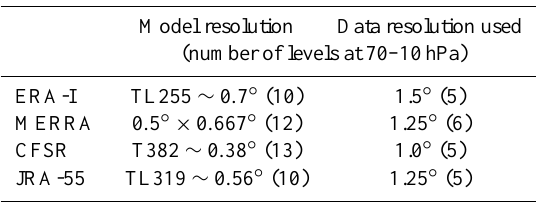
Table 1. Horizontal resolution of the native models and pressure- level data sets for the four reanalyses used in this study, along with the number of vertical levels at